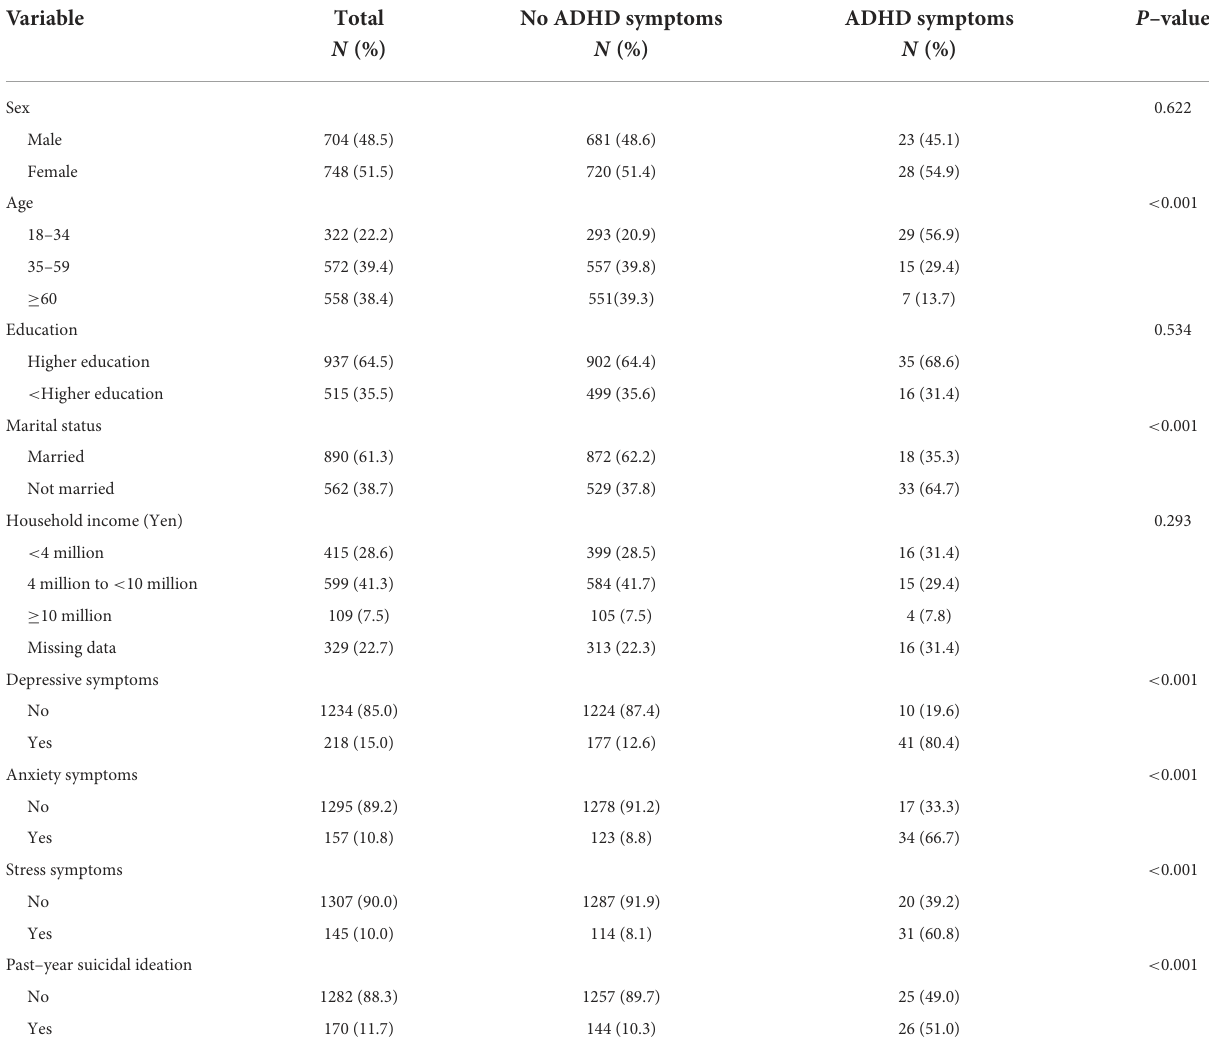
TABLE 1 Sample characteristics by ADHD